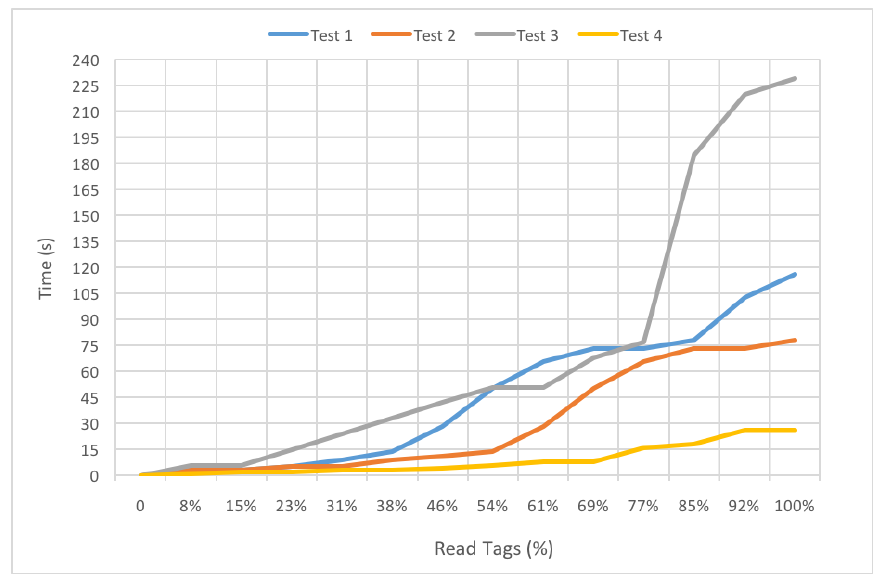
Figure 11. Percentage of read tags during four inventory flights. Table 4. Example of the collected inventory